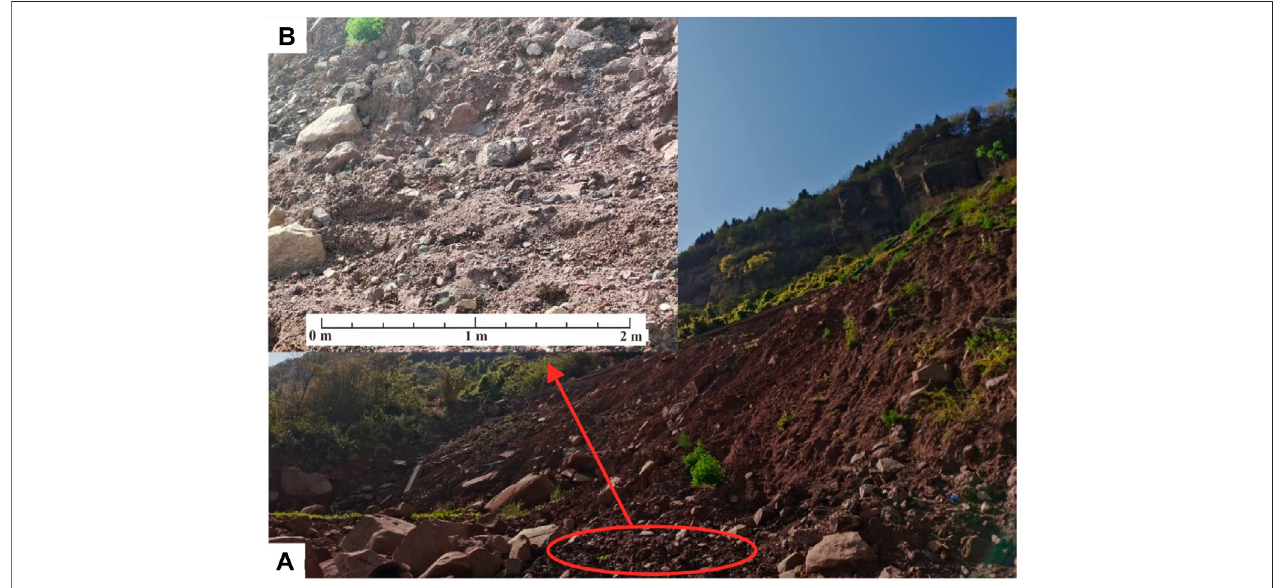
FIGURE 1 | Tuanshiban S-RMs landslide in the upstream of the Yangtze River: (A) S-RMs slope after instability failure; (B) main material of Tuanshiban S-RMs landslide.